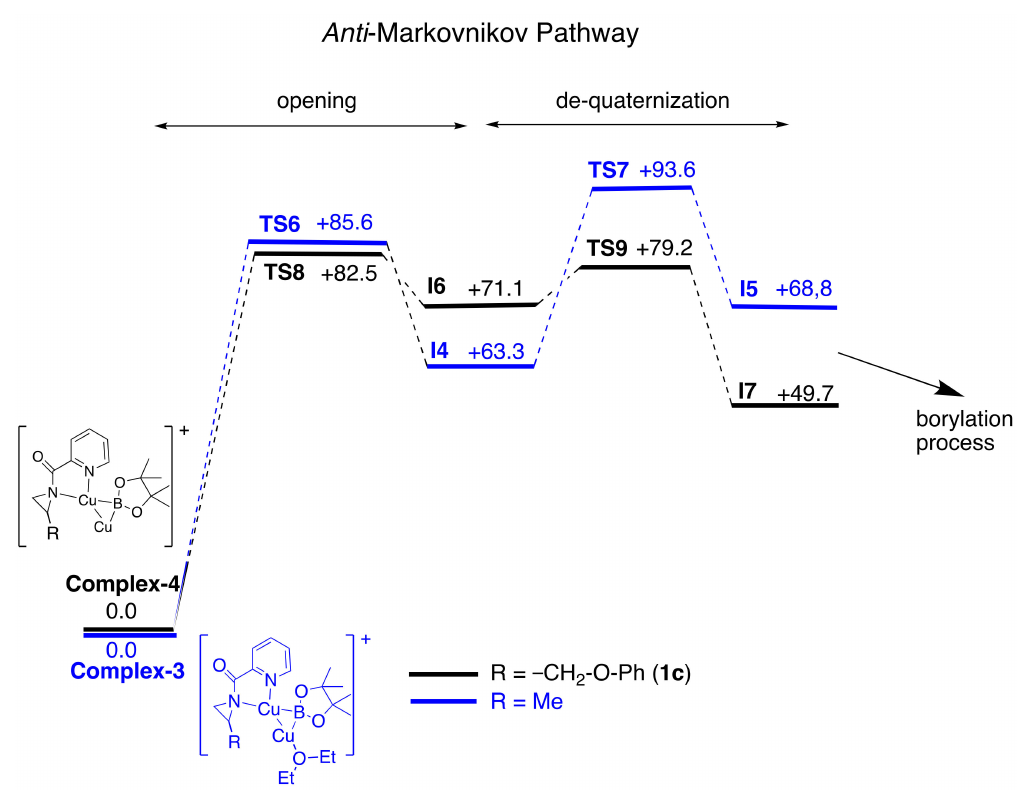
Figure 5. Particular of the reaction energy profile comparison of the anti -Markovnikov pathway between 1c (without the Et 2 O molecule; black) and N -2-picolinoyl-methyl aziridine (with the Et 2 O molecule; blue). The ∆ G values are in